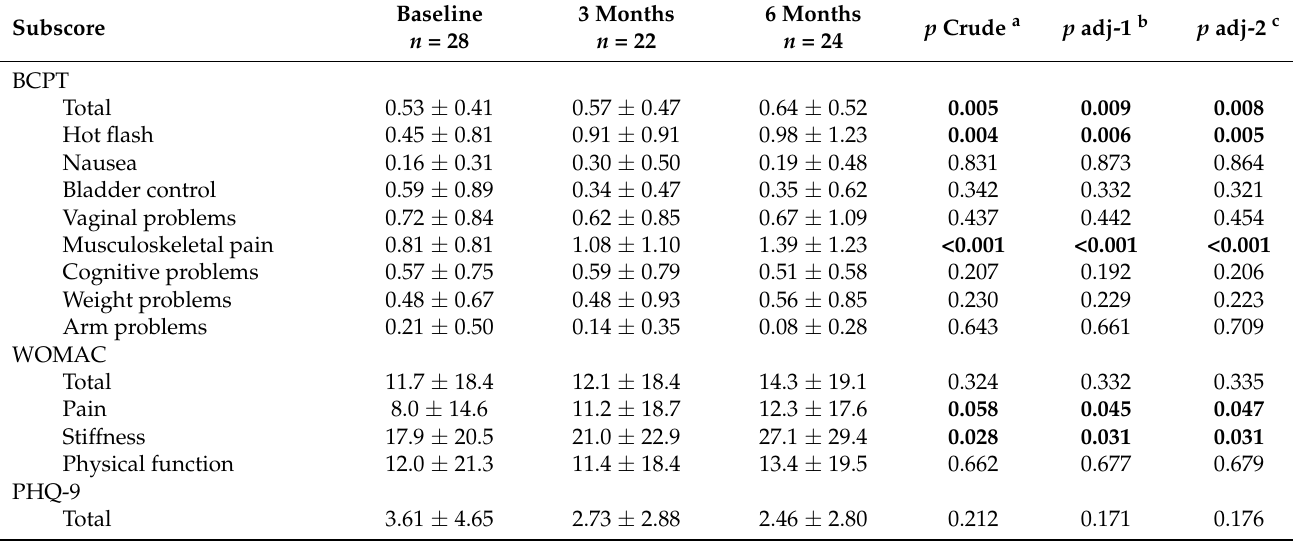
Table 2. Symptom scores across time, mean ±